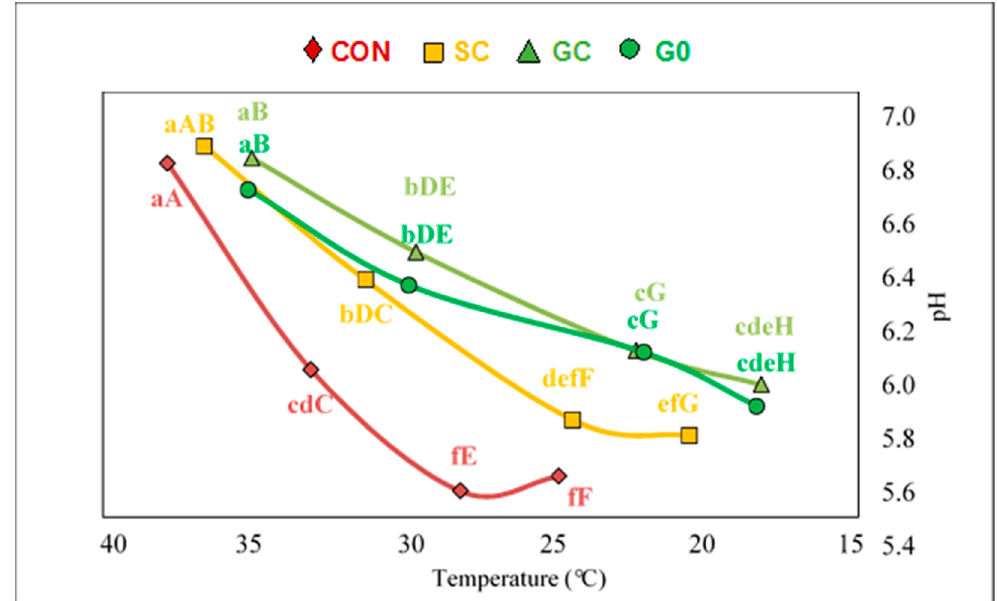
Figure 1. Pattern of pH / temperature decrease post-mortem (1, 3, 5 and 7 h) of longissimus muscle from bulls assigned to one of the following systems: grass silage plus barley-based concentrate ad libitum (CON); grass silage ad libitum plus 5 kg of concentrate (SC); grazed grass without supplementation (G0) or grazed grass plus 0.5 kg of the dietary dry matter intake as concentrate (GC) until slaughter at 15 months. a,b,c,d,e,f Di ff erent lowercase letters indicate statistical di ff erences in pH ( P < 0.05). A,B,C,D,E,F,G,H Di ff erent uppercase letters indicate statistical di ff erences in temperature ( P < 0.05).